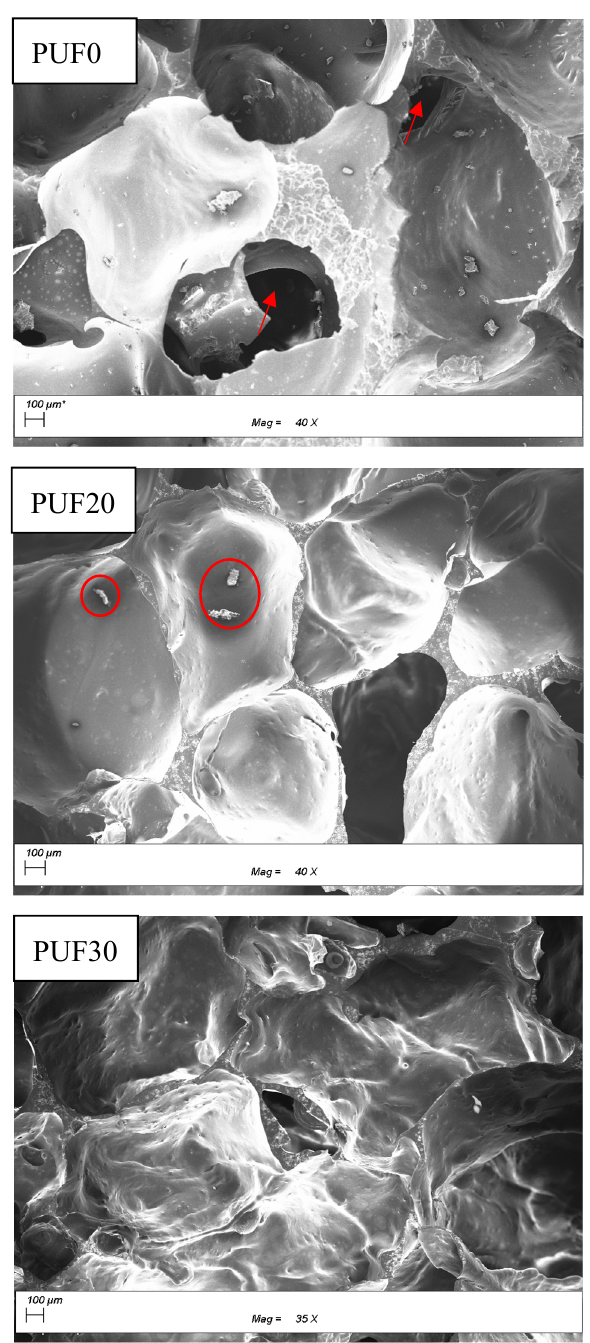
Figure 1. Scanning electron microscopy (SEM) images of PUF modified with different amount of CNF (0–30%).